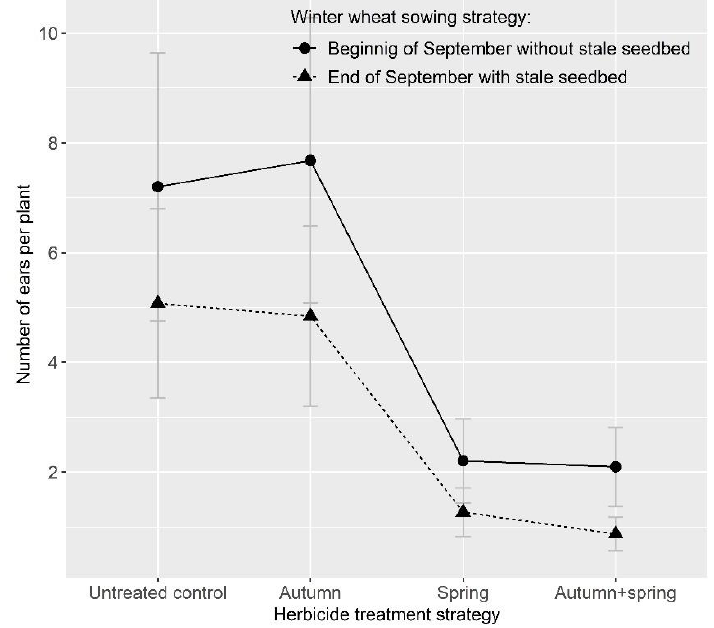
Figure 3. Number of Alopecurus myosuroides ears per plant as a function of herbicide treatment strategy and winter wheat sowing strategy.